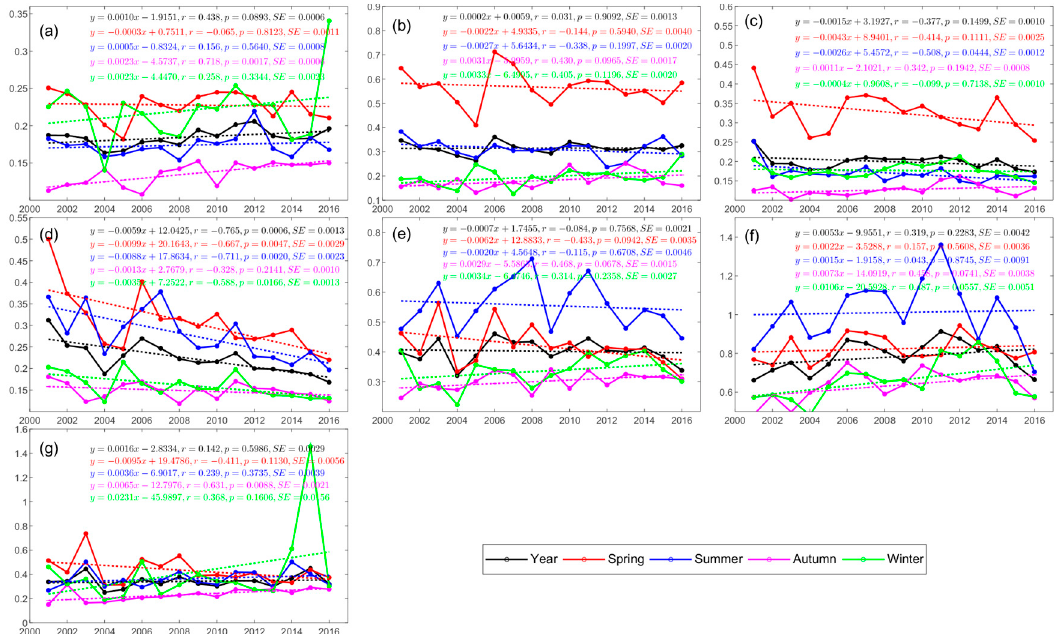
Figure 6. Annual and seasonal AOD time series averaged for the period 2001–2016 for ( a ) northern Xinjiang, ( b ) southern Xinjiang, ( c ) Qinghai Tibet, ( d ) Northwest China, ( e ) North China Plain, ( f ) East China, and ( g ) Northeast China, together with the slopes, correlation coefficient (r), two-sided p-value (p), and standard error (SE) of the linear trends.